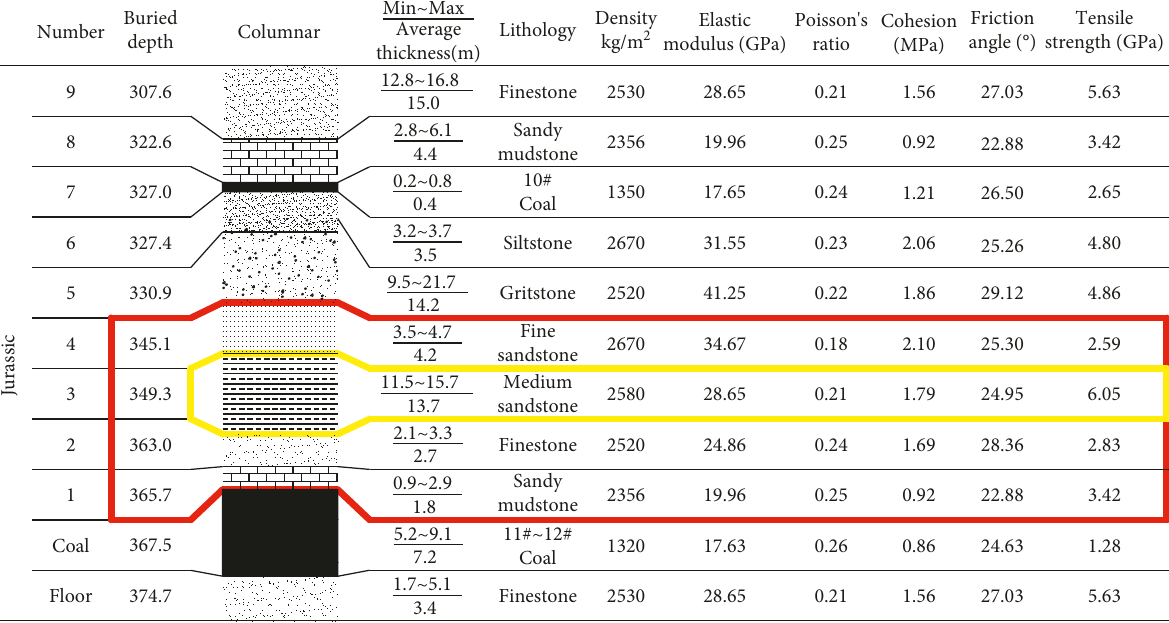
Figure 2: Local lithological